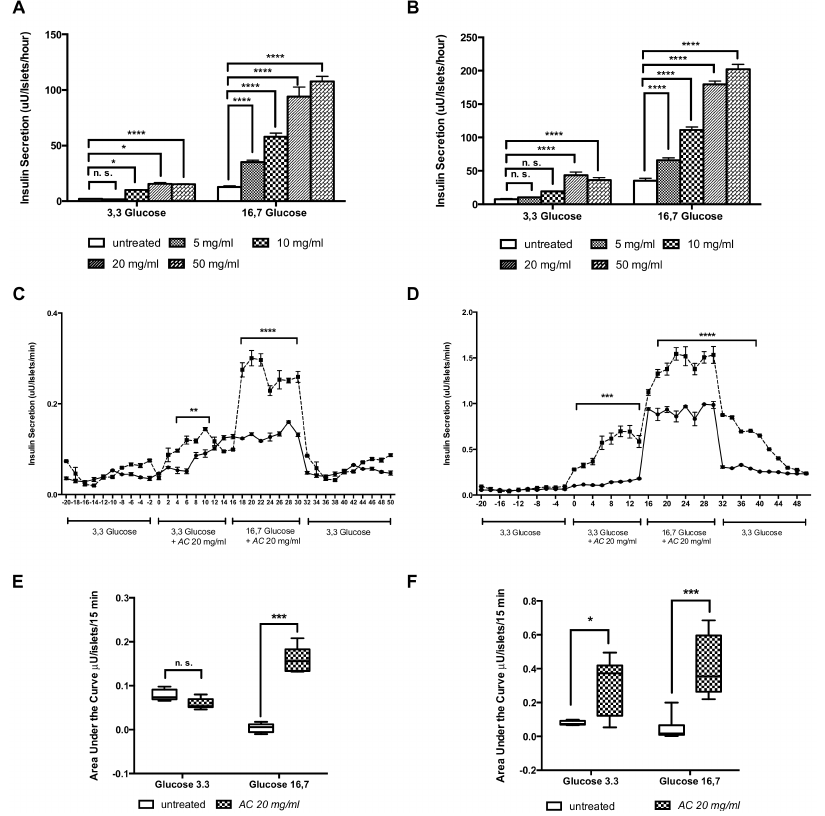
Figure 7. AC stimulates the in vitro insulin secretion in pancreatic islets. Insulin secretion was evaluated in GK rat islets ( A ) and W rat islets ( B ) cultured at low (3.3 mM) and high (16.7 mM) glucose in presence of AC (5–200 mg/mL). Data are presented as means ± SEM ( n = 8). Batches of (50) GK ( C ) and Wistar ( D ) rats islets were perifused with 3.3 mM glucose, from time 0 to 14 min, and with 16.7 mM glucose, from time 16 to 30 min, in presence --- (cid:4) --- or absence — — of AC (20 mg/mL). The AUC of the insulin secretion from the intervals at 3.3 mM and 16.7 mM of glucose in presence or absence of AC was calculated for GK ( E ) and W ( F ). rats islets. Data are presented as means ± SEM ( n = 4). * p < 0.05, ** p < 0.01, *** p < 0.001, **** p < 0.0001 when compared to untreated